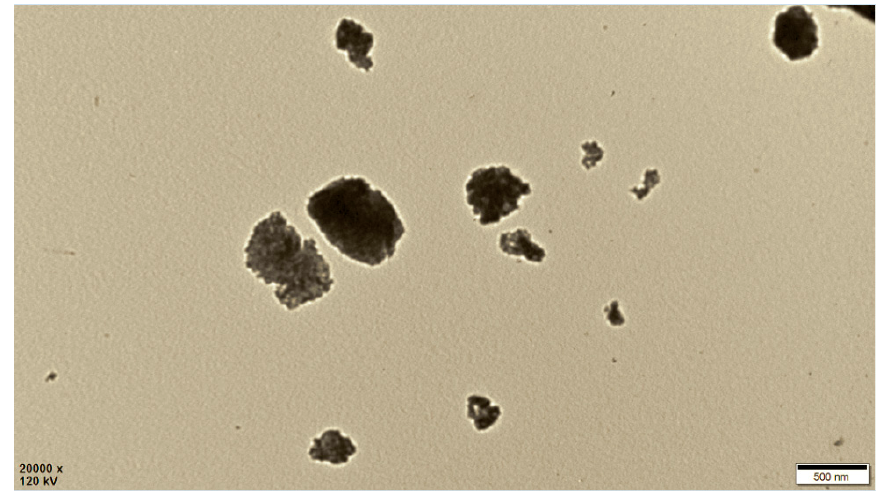
Figure 4. TEM image of SiNPs.